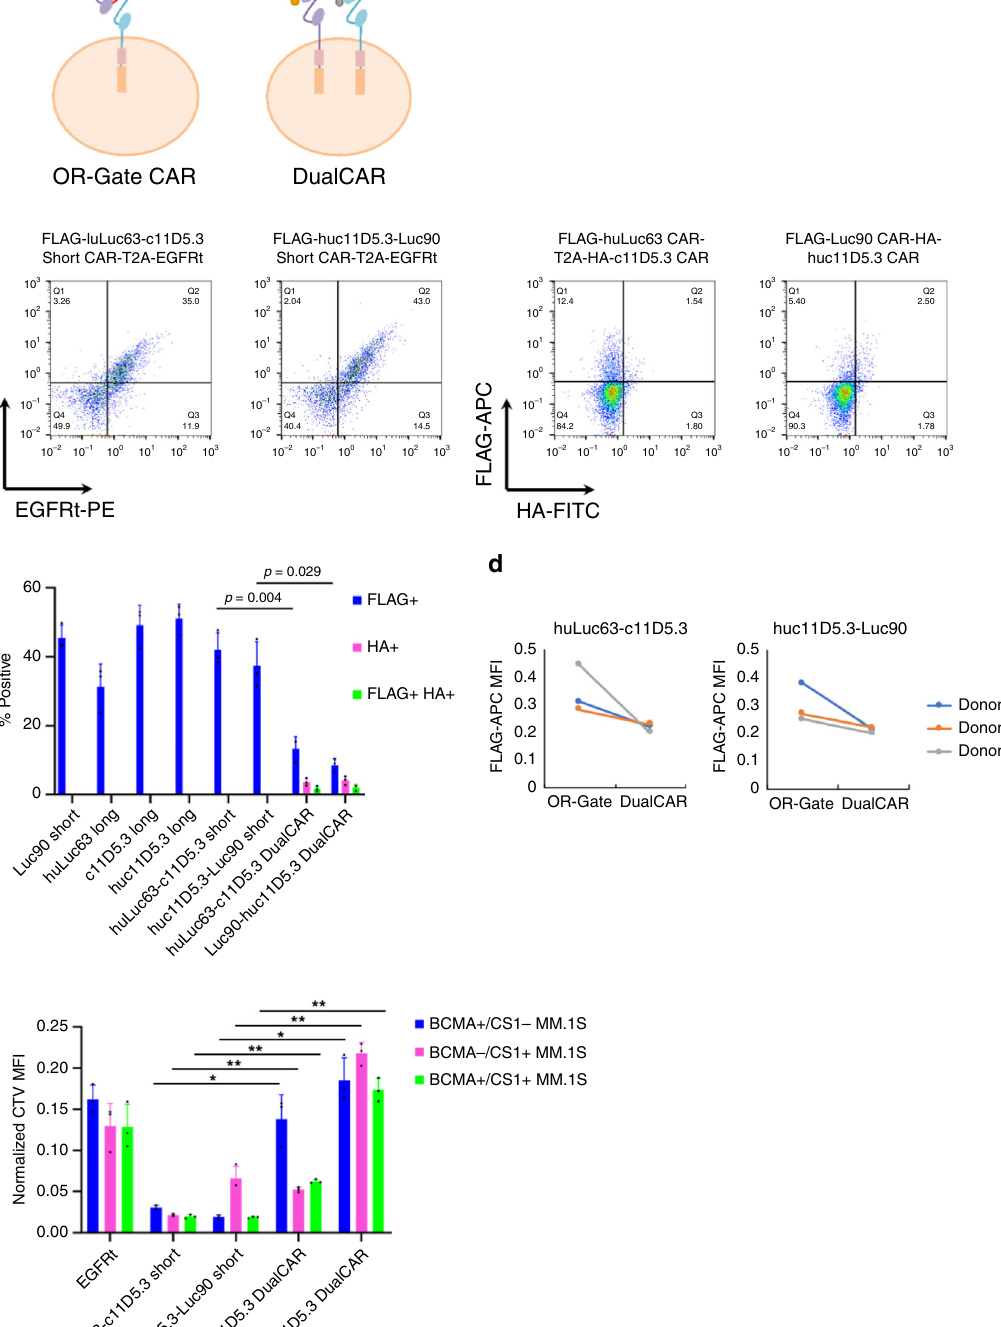
FLAG-huLuc63 CAR- T2A-HA-c11D5.3 CAR